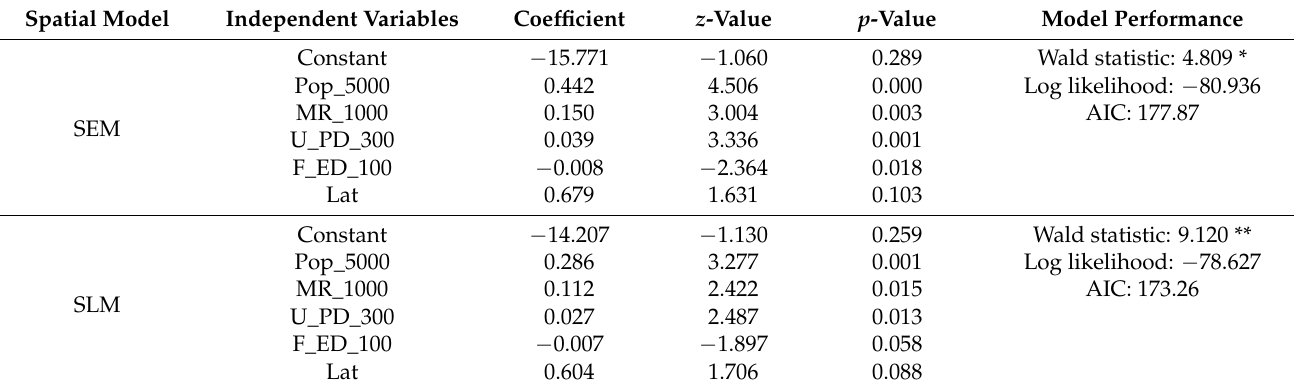
Table 4. Results of the spatial regression models for PRH (* p < 0.05, ** p < 0.01).